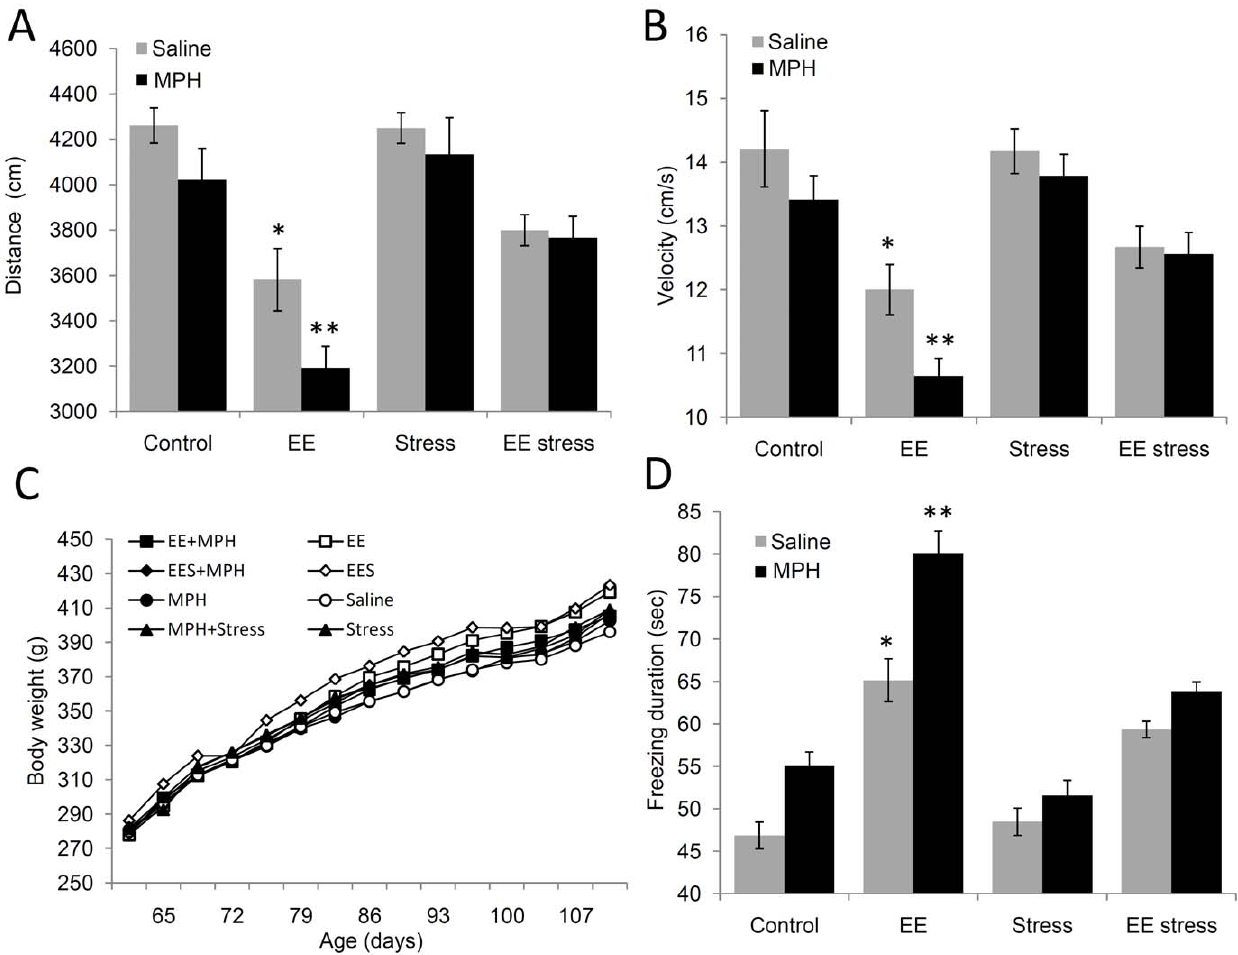
Figure 2. The effect of MPH on locomotor activity. A significant difference in distance (A) and velocity (B) were detected between the groups in the open field test. Rats exposed to MPH following EE showed the lowest distance and velocity. These effects were not related to differences in body weight (C). MPH treatment significantly increased freezing duration (D) compared to saline. Following EE, MPH led to the highest freezing duration. * P , 0.0001 versus control; ** a: P , 0.022, b: P , 0.008, c: P , 0.0001 versus EE saline; n=9 to 10 per group.